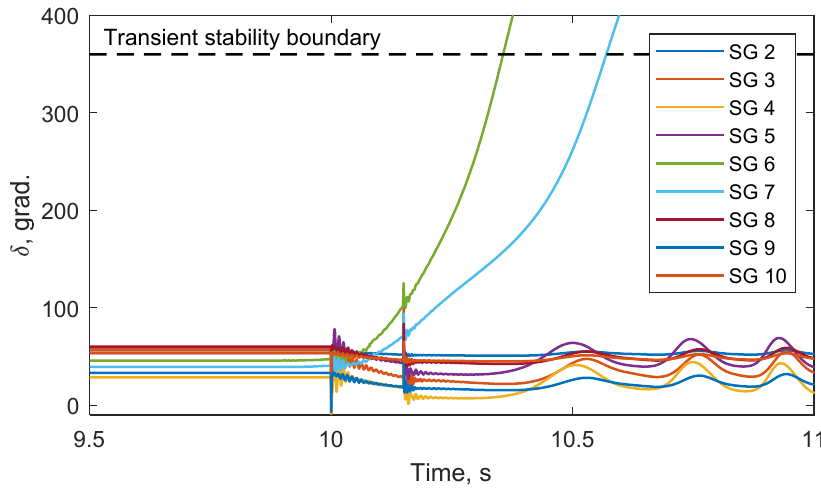
Figure 2. Example of a transient leading to instability of Generators SG6 and SG7.